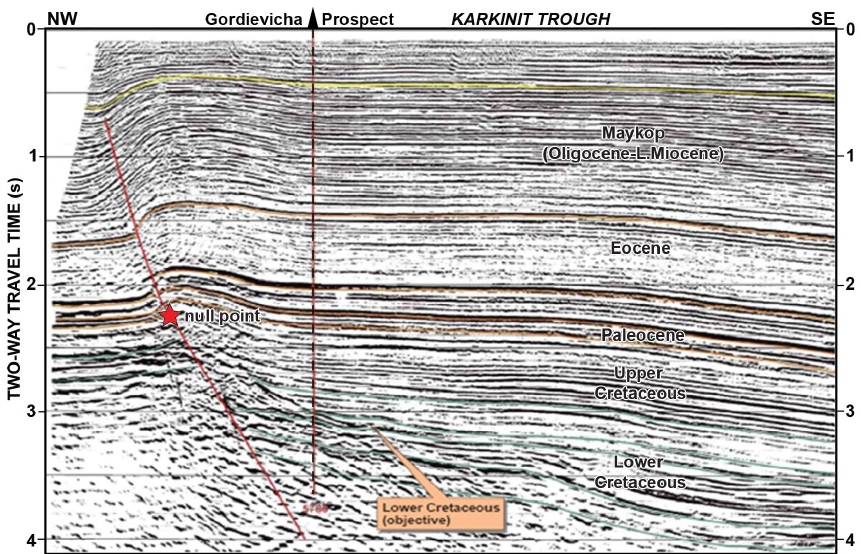
Figure 11. Legacy 2D seismic reflection profile across the undrilled Gordievicha prospect, adapted from Burchell (2008). For location, see Fig. 8. The position of the null point, sensu Williams et al. (1989), is shown by a red star.